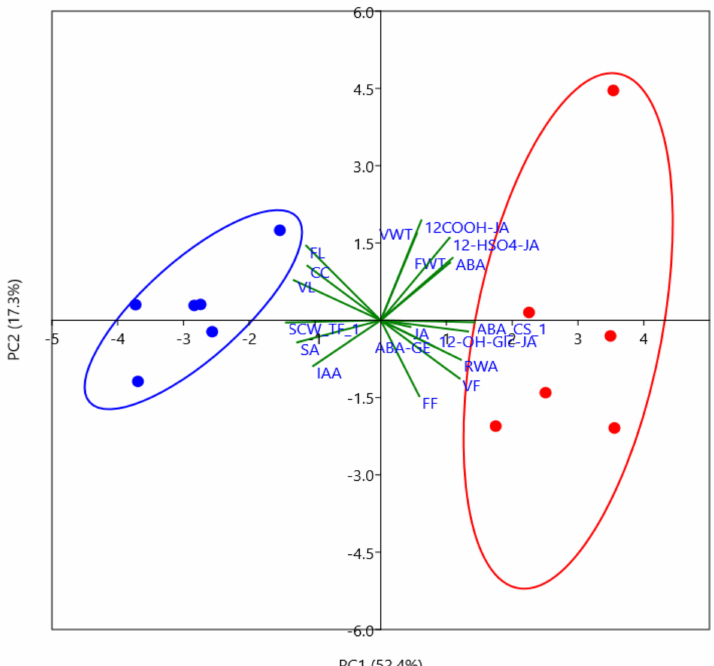
Figure 8. Principle component analysis (PCA) of wood anatomical traits, phytohormone concentra- tions and transcript abundances of genes involved in ABA signaling and the secondary cell wall (SCW) cascade in poplar (hybrid T89) wood. Red dots indicate drought-treated and blue dots well- watered samples. Abbreviations: ABA: abscisic acid, ABA-GE: ABA glucose ester, IAA: indole acetic acid, JA: jasmonic acid, SA: salicylic acid, 12HSO4-JA: 12-hydroxy jasmonoyl sulfate,